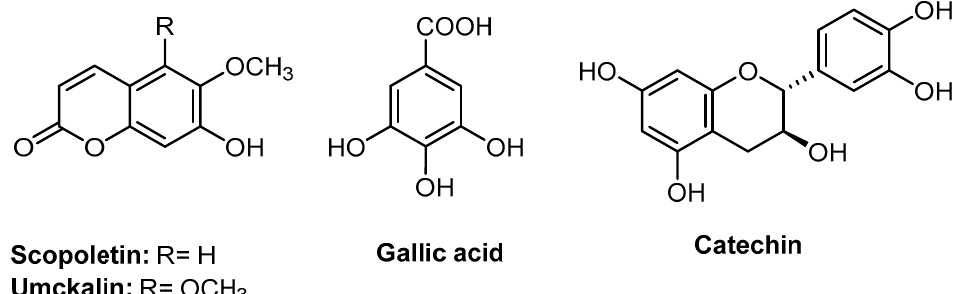
Figure 2. Analytical standards used in the phytochemical distinction between Pelargonium × hortorum cultivars and Pelargonium sidoides .